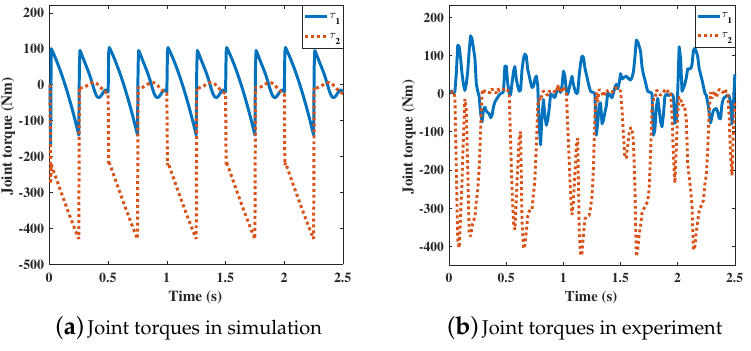
Figure 11. The joint torques of the RF leg.